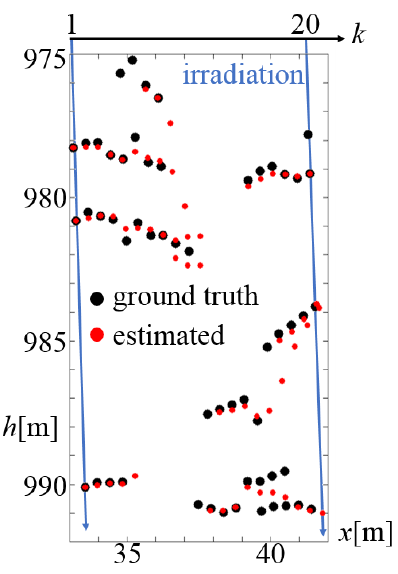
Figure 9. Estimated results on x - h coordinates Figure 8. Estimated